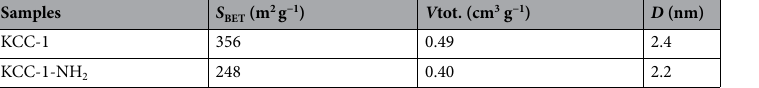
Table 1. Textural properties of mesoporous silica KCC-1 and KCC-1-NH 2 according to the BET and BJH models. S BET specific surface area according to the BET method, V tot. total pore volume, D BJH average pore diameter.